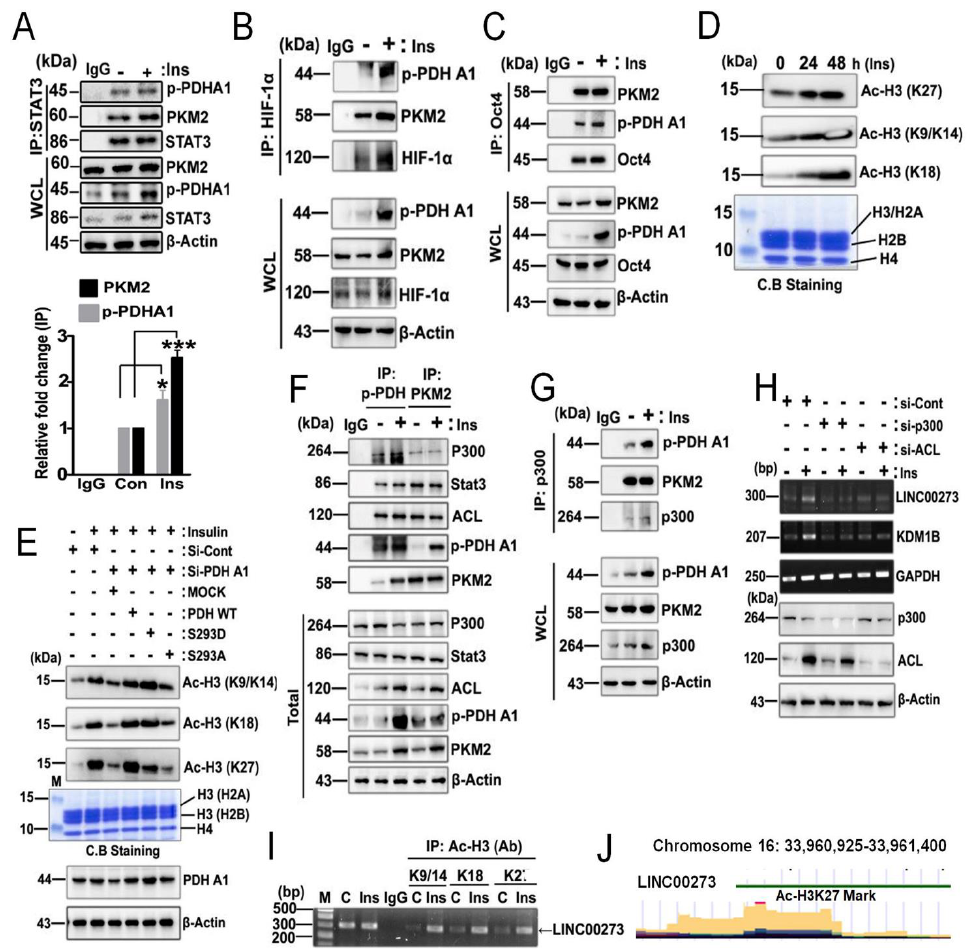
Figure 5. Regulation of Histone acetylation through p − PDHA1/PKM2 Complex upon insulin stimulation. ( A – C ) HepG2 cells were stimulated with Insulin (100 nM at 24 h), and STAT3, HIF-1 α , and Oct4 were immunoprecipitated, and p-PDHA1 and PKM2 were detected by Western blotting. ( D ) HepG2 cells were treated with insulin (100 nM) in indicated time, and acetylated histones (Ac-H3K27, Ac-H3K9/14, and Ac-H3K18) levels were measured from extracted histone proteins by Western blotting. Histone proteins were visualized by Coomassie blue staining in SDS-PAGE (lower panel). ( E ) HepG2 cells were knockdown with si-PDHA1, then addback with PDH WT, 293D, and 293A mutant, and then stimulated with insulin (100 nM at 24 h), and indicated proteins were de- tected. ( F ) Insulin (100 nM at 24 h) stimulated HepG2 cells lysate were immunoprecipitated with PKM2, p-PDHA1, and then p300, STAT3, and ACL levels were detected. ( G ) HepG2 cells stimulated by insulin (100 nM at 24 h), cell lysates were used for immunoprecipitation with p300 HAT antibody, and then co-immunoprecipitated p-PDHA1 and PKM2 were determined by Western blotting. ( H ) LINC00273 and KDM1B mRNA levels were measured through RT-PCR from HepG2 cells, which were knockdown with si-ACL and si-p300 and stimulated with or without insulin (100 nM at 24 h) treatment. ( I ) ChIP-PCR of LINC00273 genes was performed after immunoprecipitation of several acetylated histone proteins by using Ac-H3K9/14, Ac-H3K18, and Ac-H3K27 antibodies in the pres- ence of insulin (100 nM at 24 h). ( J ) Acetylated H3K27 in the promoter region of LINC00273 was